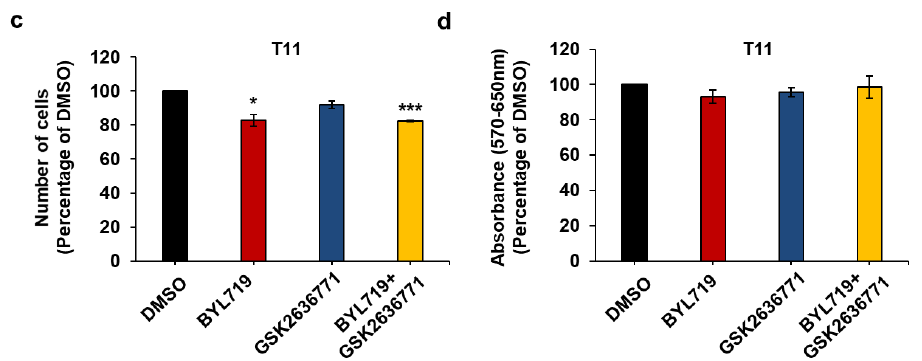
Figure 9. p110 β does not compensate for p110 α inhibition in IC1 and T11 cells. IC1 ( a , b ) and T11 ( c , d ) cells were treated with 1 µM of the indicated inhibitors alone or in combination in complete medium supplemented with 10% FBS. Control cells were treated with DMSO. After 72 h, number of cells was assessed by cell counting ( a , c ) and cell viability was assessed by MTT assays ( b , d ). Data are expressed as percentage of results from control cells and are means ± SEM from n = 4 ( a ), n = 7 ( b ) and n = 3 ( c , d ) independent experiments performed in duplicate ( a , c ) or triplicate ( b , d ). * p < 0.05, ** p < 0.01, *** p < 0.001.